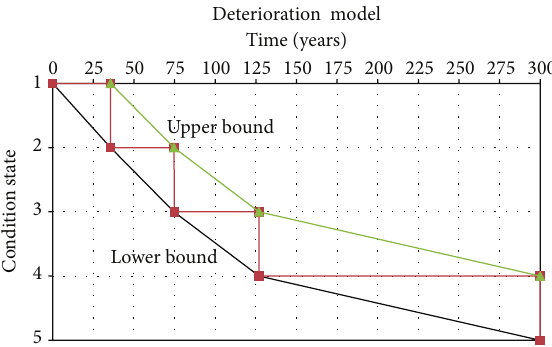
Figure 11: Markov chain deterioration